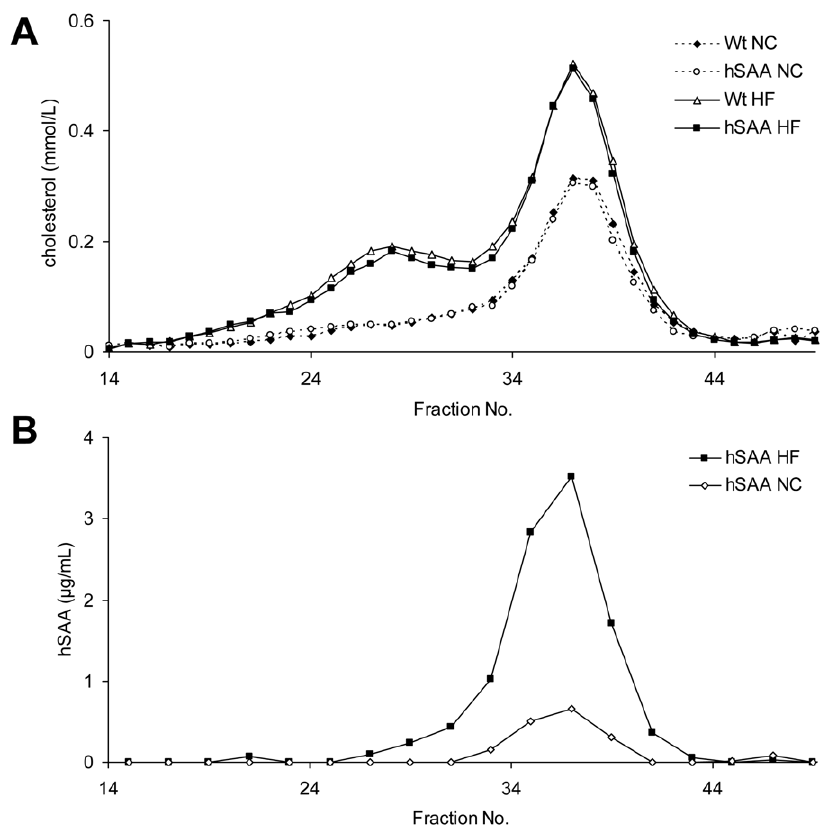
Figure 4. Distribution of cholesterol and hSAA in lipoproteins. Pooled plasma samples from transgenic (hSAA) and wild type (Wt) male animals fed either NC or HF diet (n=7–10 per group) were subjected to FPLC as detailed in ‘‘Methods’’. ( A ) Cholesterol levels in plasma FPLC fractions from Wt and hSAA animals. ( B ) hSAA levels in plasma FPLC fractions from hSAA animals.